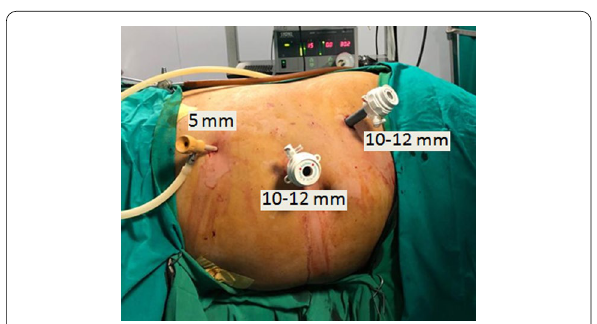
Fig. 3 Completely dissecting renal artery and vein (left